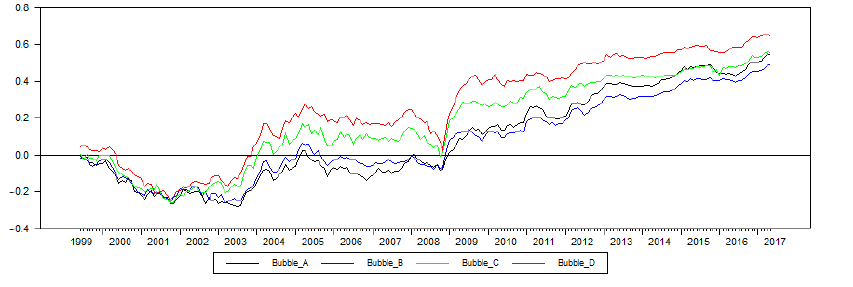
Figure 1. House price bubbles Table 1. Estimation results of the state-space model Table 2. Unit root and cointegration tests of house price bubbles Panel A: The augmented Dickey-Fuller test results